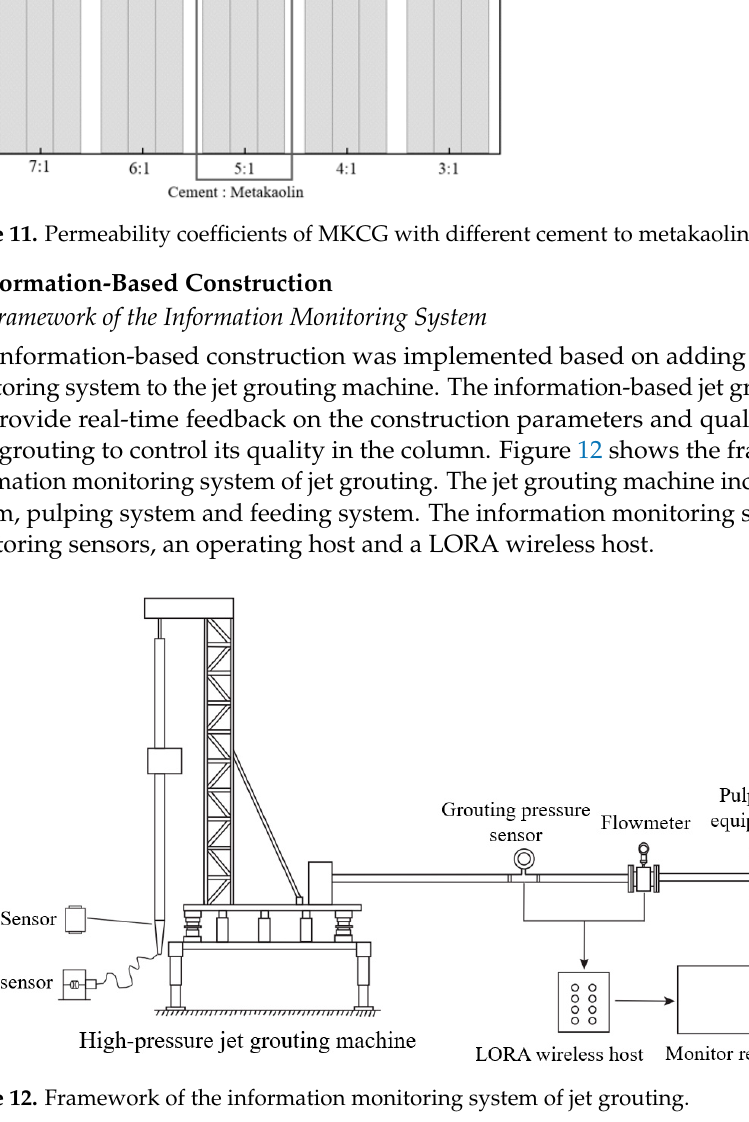
( d ) Figure 13. Installation of monitoring sensors. ( a ) Flowmeter. ( b ) Speed sensor. ( c ) Depth sensor. ( d ) Pressure sensor.